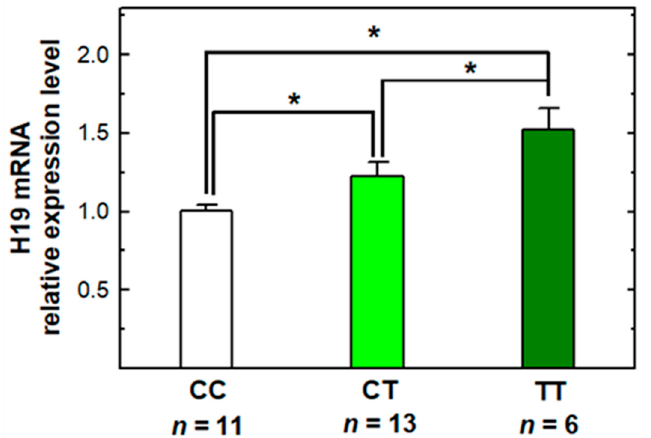
Figure 1. Comparison of H19 mRNA expression levels with different H19 rs2839698 genotypes. Quantitative real-time polymerase chain reaction (RT-PCR) for three genotypes of H19 rs2839698 from childhood leukemia patients was conducted and glyceraldehyde 3-phosphate dehydrogenase (GAPDH) was used as internal control. Fold changes were normalized by the GAPDH expression. * p -values < 0.05.